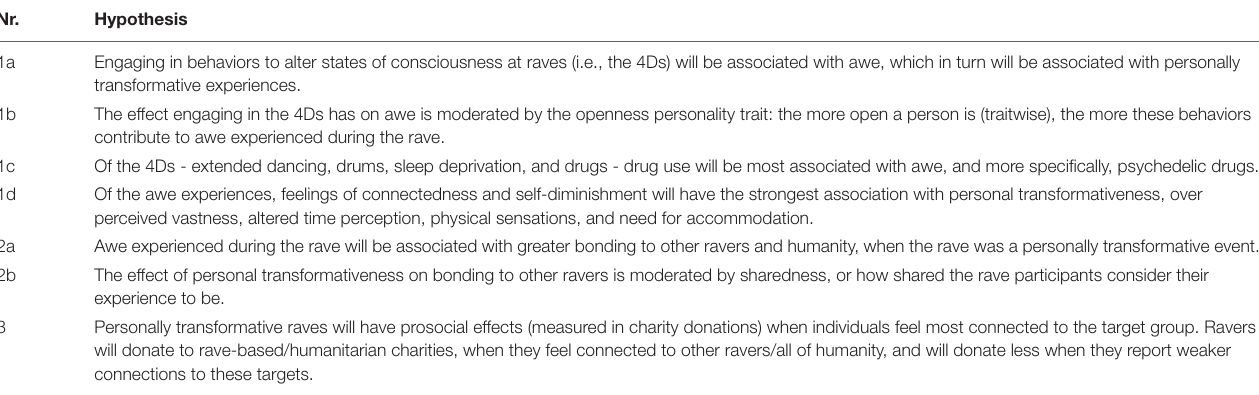
TABLE 1 | Overview of pre-registered hypotheses of the current study.